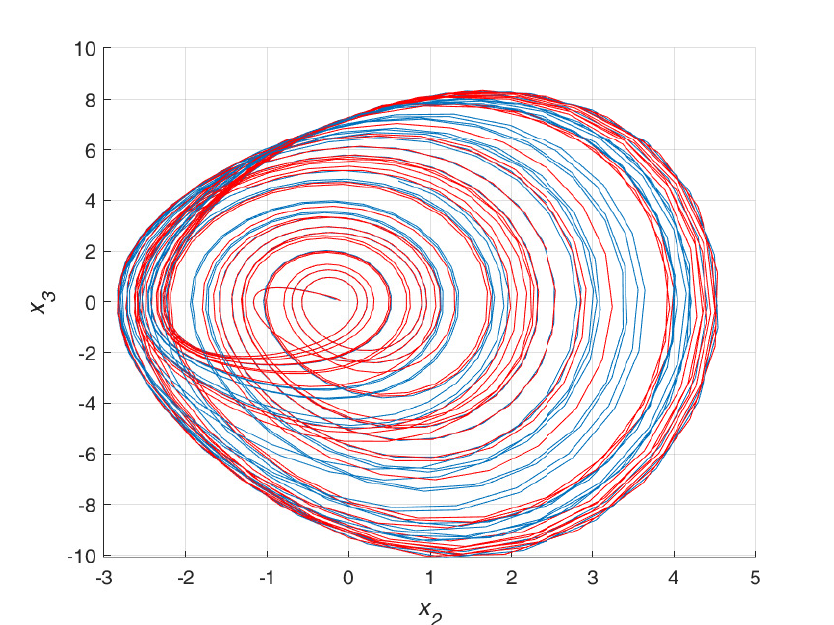
Figure 3. Sensitivity dependence on the initial conditions: Two sets of initial conditions (0.1, 0.1, 0.5) & (0.5, 0.5, 0) with β =